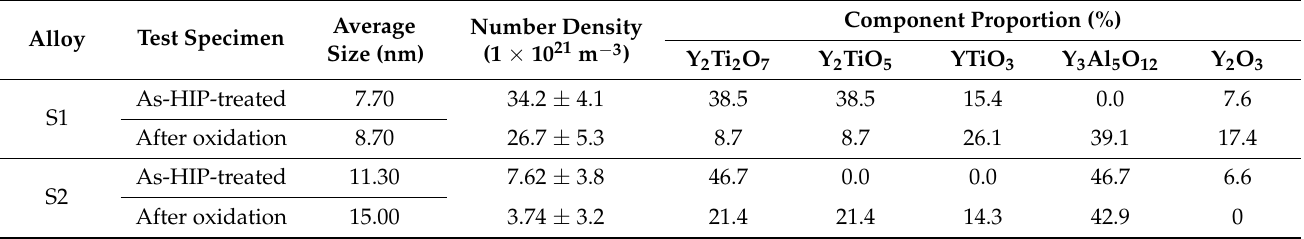
Table 2. Summary of characteristics and constituents of nanometric oxides for the nickel-based ODS